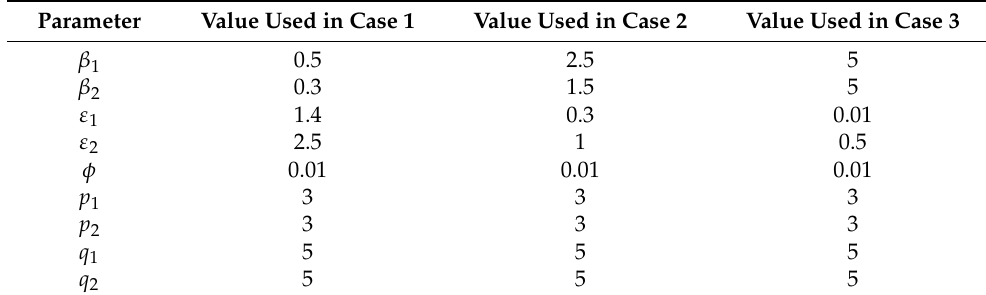
Table 3. Controller parameters for the circular